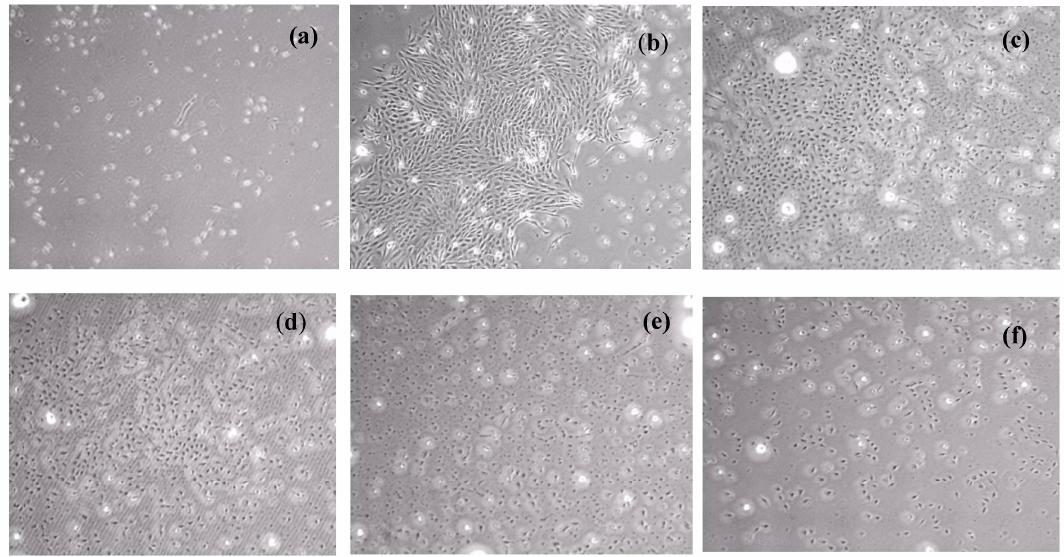
Figure 8. L929 fibroblasts cultured for three days with ( a ) positive control; ( b ) negative control; ( c ) PLA; ( d ) PLA/MWCNT-Ag 0.1 ; ( e ) PLA/MWCNT-Ag 0.2 ; and ( f ) PLA/MWCNT-Ag 0.3 . (L929 fibroblasts